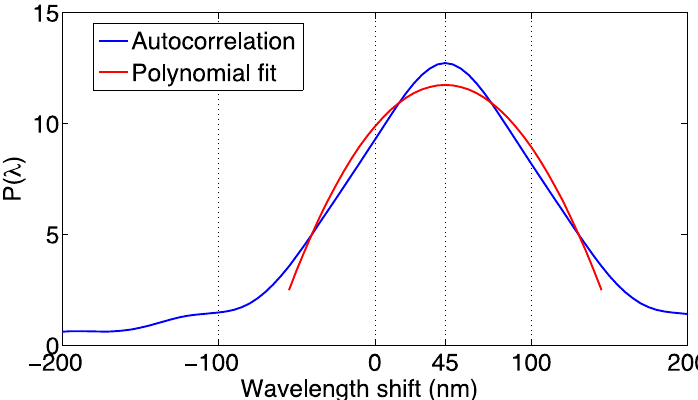
Figure 10. Sketch of the mutual correlation based peak tracking with wavelength shifting. ( Left ) reference and shifted spectra simulated over the wavelength resolution δλ = 5 pm; the shifted spectrum has 45 pm wavelength shift. ( Right ) the mutual correlation P m is calculated over all the wavelength shift values, identifying the wavelength shift as the value that maximizes P m : this coincides with the wavelength shift.